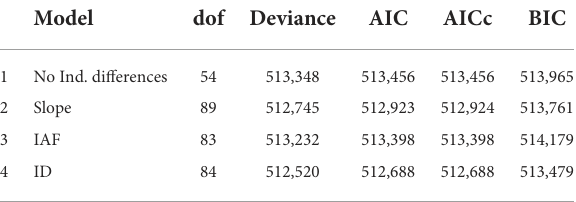
The table shows goodness-of-fit metrics for the best-fitting model without individual differences in comparison to the models including aperiodic (1/f) slope, IAF, and